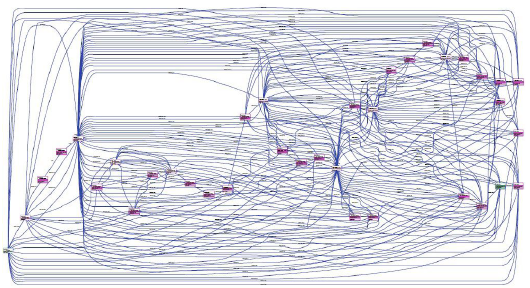
Figure 4. Complexity of modeling communication flow between two devices with Discrete Time Markov Chain (DTMC) and packet-level details